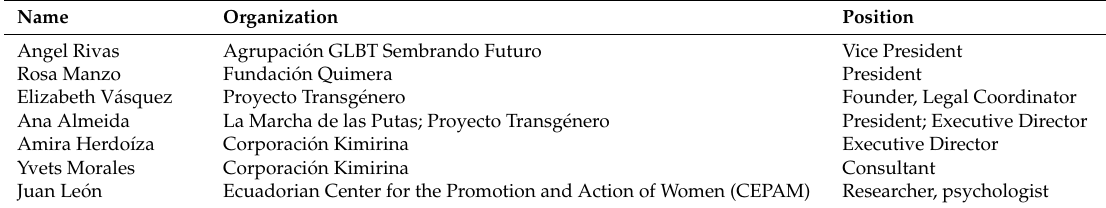
Table A6. Interviews with other NGOs in Ecuador.